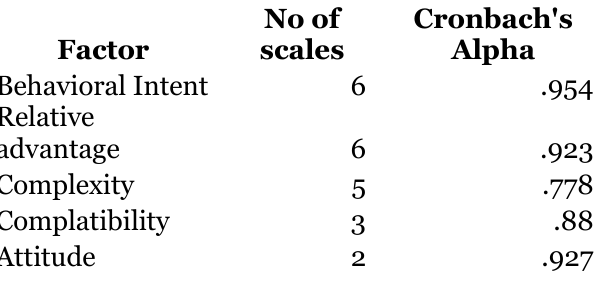
Cronbach’s Alpha